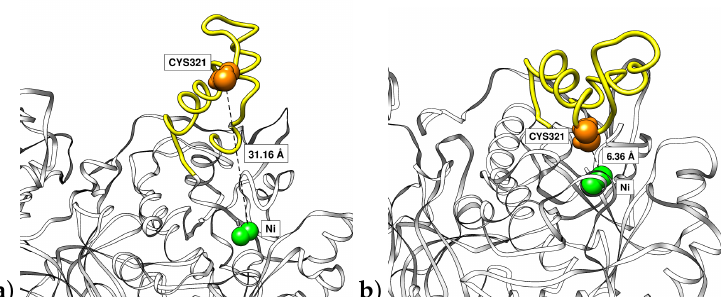
Figure 9. Final snapshots of one urease flap (yellow) in the simulations at ( a ) pH 2 in open conformation and ( b ) pH 7.5 in closed conformation. Ni + 2 ions are represented in green. Distances of Ni + 2 to Cys321 (orange) are also indicated.